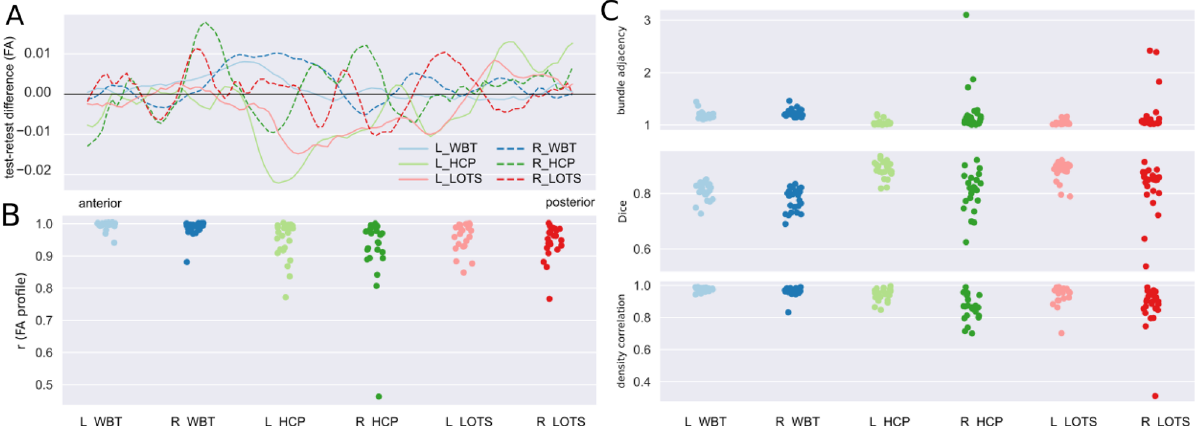
Figure 4. Evaluation of test–retest reproducibility for arcuate fasciculus tracking across three procedures. ( A ) Per procedure/hemisphere across-subject mean FA tract-profile differences between the test and retest acquisitions. ( B ) Strip plots showing the distribution of the correlation coefficients between test and retest computations for each tract and each subject. ( C ) Macrostructural agreement indices distribution: bundle adjacency (top), Dice coefficient (middle), and density correlation (bottom) for test and retest computations for each tract and each